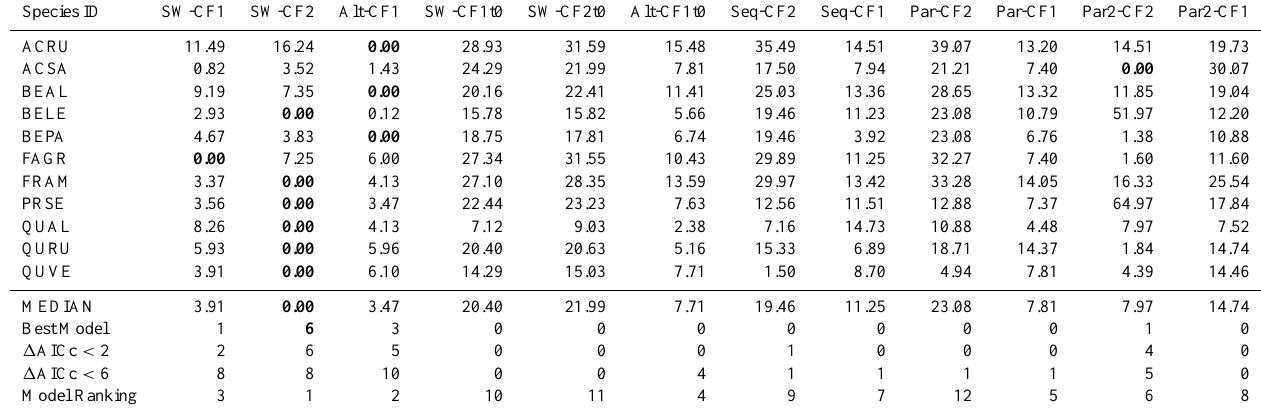
Table 3. 1 AICc values for a range of different models (see text and Tables 1, 2 for additional information) fit to Harvard Forest bud-burst data. Species ID are as given in Table 1. The best model, based on Akaike’s Information Criterion corrected for small samples (AICc) has 1 AICc = 0 and is indicated by bold